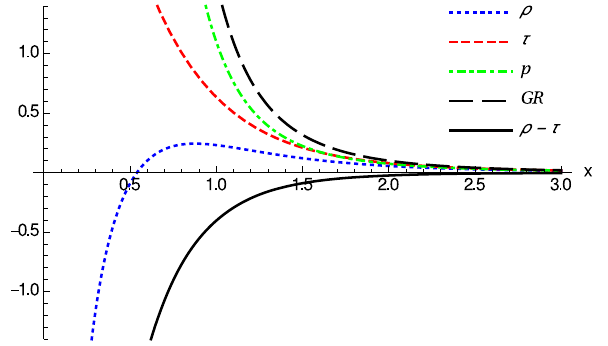
Fig. 5 Same notation and curves as in Fig. 2, now with δ 1 = δ c + 0 . 3 and N q = N (cid:18) c + 10, corresponding to Reissner–Nordström-like configurations without horizons (naked). Note that the NEC is violated because ˜ ρ − ˜ τ < 0 (solid black line) around the wormhole throat x = 0. Here ˜ ρ and ˜ τ diverge as 1 / | x | when | x | →